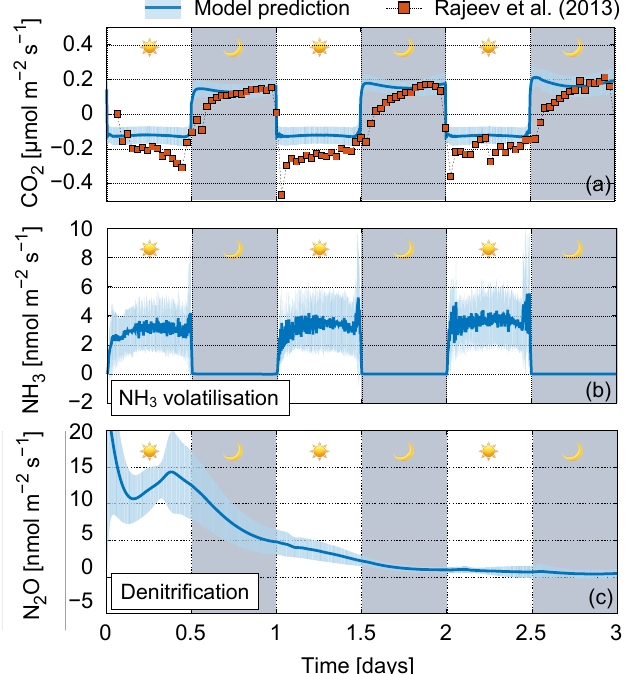
Figure 9. Gas effluxes from saturated biocrusts. Gaseous efflux from saturated biocrusts is concomitantly obtained with chemical profiles and microbial activity from 10 independent simulations of the model. (a) CO 2 efflux shows diel cycles of uptake (during daytime) and release (during nighttime). The averaged CO 2 efflux dynamics are compared with an observation (red squares from Rajeev et al., 2013). (b) NH 3 efflux dynamics show volatilisation of ammonia gas mainly caused by alkalisation of the top crust during daytime, resulting in a net volatilisation rate of about 500nmolm − 2 day − 1 . (c) N 2 O efflux is also calculated as an indicator of denitrification. The highest denitrification rate is observed during the first 1–2